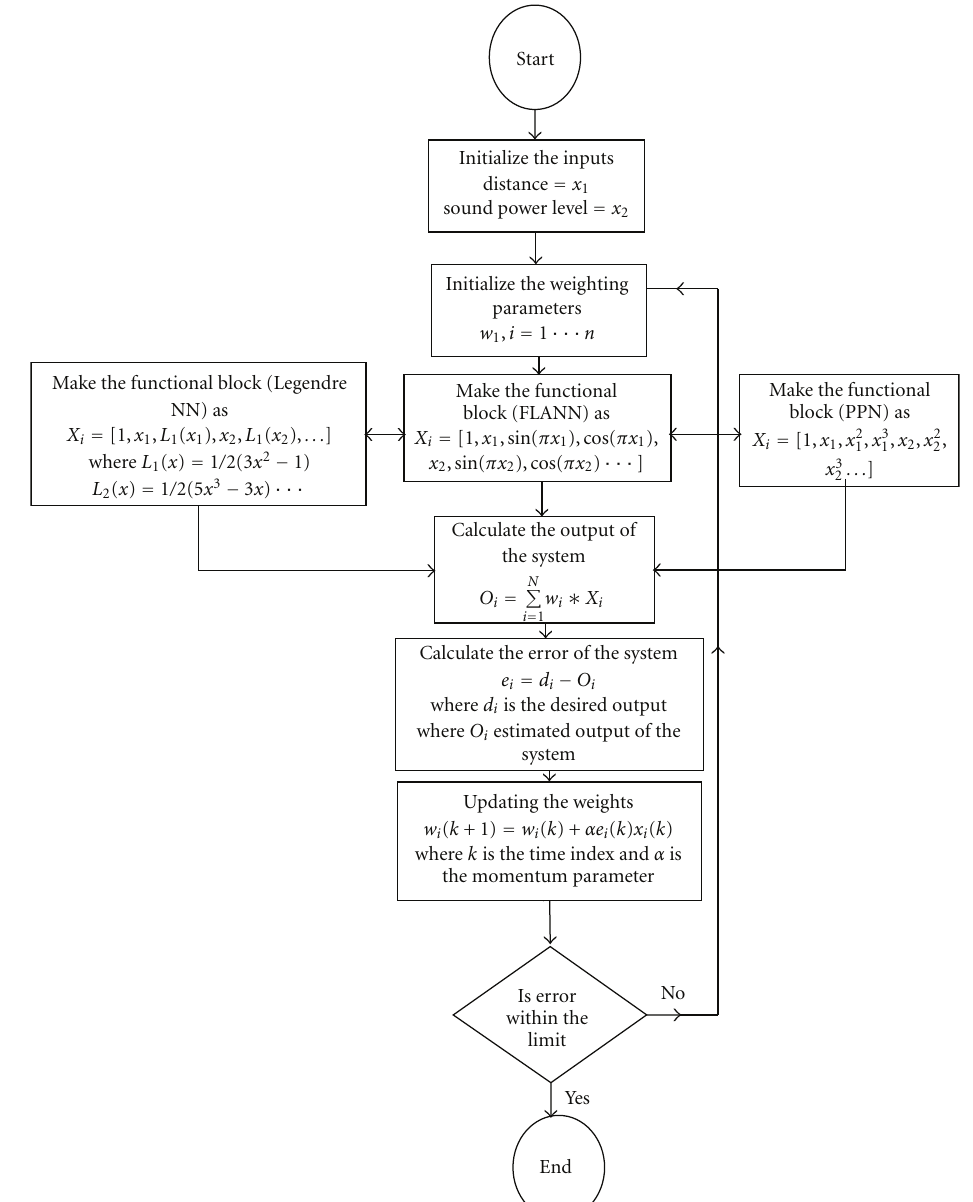
Figure 2: Systematic algorithm of functional based neural network based noise prediction